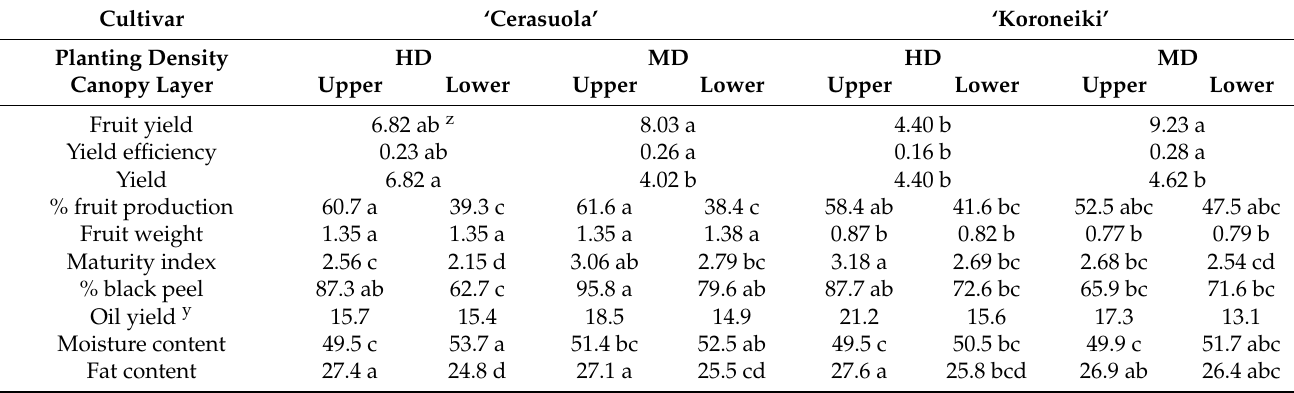
Table 2. Production and fruit quality of ‘Cerasuola’ and ‘Koroneiki’ olive trees planted at 1000 (HD) and 500 (MD) trees/ha. Production described as fruit yield (kg/tree), yield efficiency (kg cm − 2 ), yield (t ha − 1 ), percentage of total fruit harvest distributed on the upper and lower layers of the canopy, and oil yield (kg of oil 100 kg − 1 of fruit). Fruit conditions at harvest described by maturity index, percentage of black peel cover (veraison), fresh weight (g), moisture and fat content (g 100 g − 1 of fresh